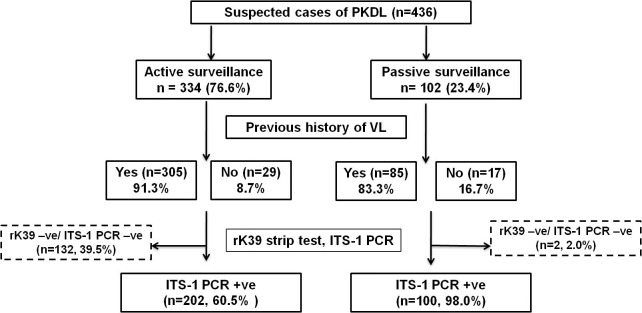
Schematic diagram indicating total number of patients recruited following active or passive surveillance in West Bengal.PKDL: Post Kala-azar Dermal Leishmaniasis, VL: Visceral Leishmaniasis, -ve: negative, +ve: positive.